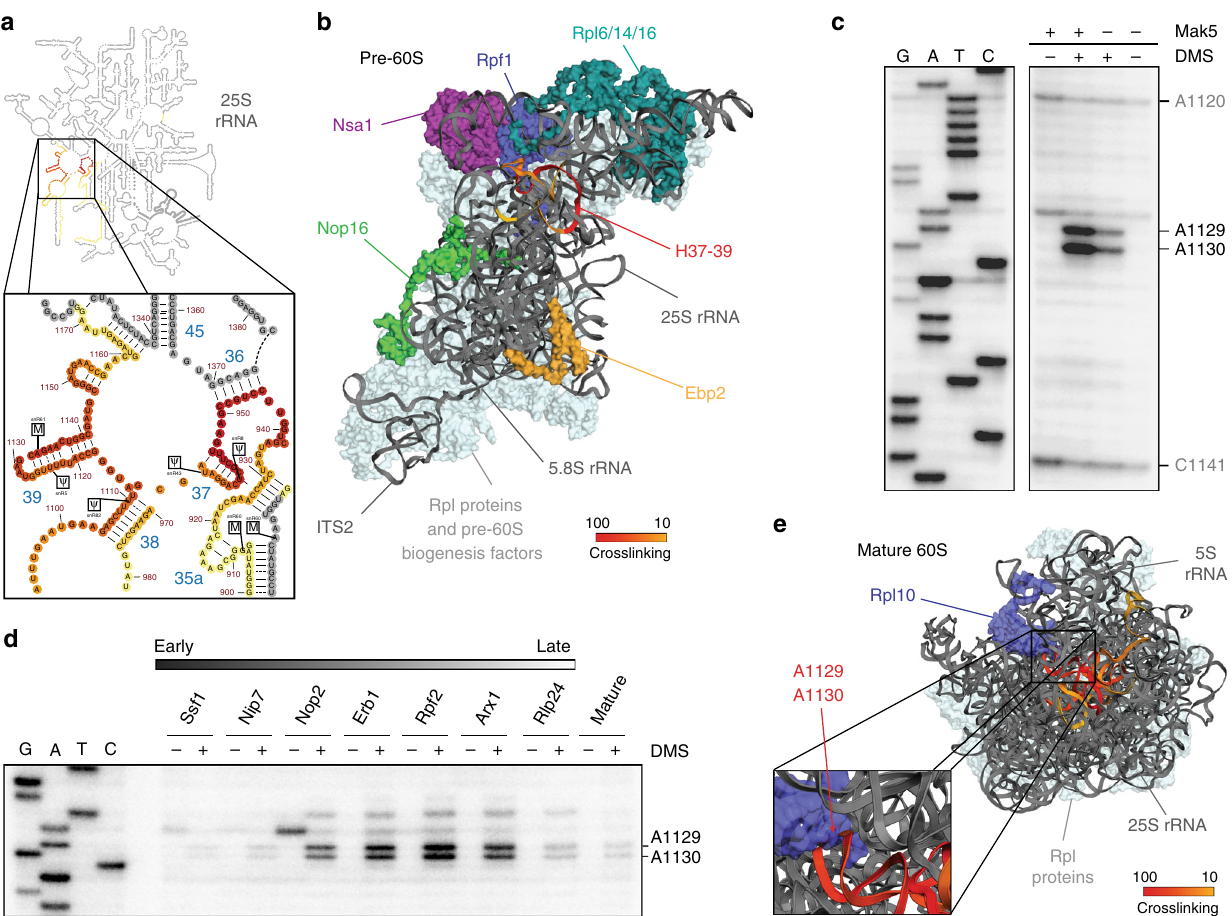
Fig. 5 Mak5 crosslinks to the 25S rRNA sequence that is later bound by Rpl10. a The number of sequence reads in the Mak5-HTP CRAC data corresponding to each nucleotide of the 25S rRNA sequence is shown on the secondary structure of the mature 25S rRNA using a colour code where the maximum number of reads (100%) is shown in red and lower numbers of reads (10%) are shown in yellow. A magni fi ed view of the Mak5 crosslinking sites in H36 – 37 and H39 is shown. b The number of sequence reads in the Mak5-HTP CRAC data corresponding to each nucleotide of the 25S rRNA sequence was modelled onto the tertiary structure of the 25S rRNA sequence in a pre-60S complex puri fi ed via Nsa1 and Nop2 (state 3; PDB: 6CB1 [https://www.rcsb.org/structure/6CB1]) using a colour code as in ( a ). Densities corresponding to speci fi c ribosomal proteins and pre-60S biogenesis factors are highlighted in various colours. c Nop2-containing pre-60S complexes puri fi ed from yeast expressing ( + ) or depleted ( − ) of Mak5 were immobilised on IgG sepharose and either treated with DMS ( + ) or left untreated ( − ). RNAs isolated from these complexes served as substrate for primer extension reactions and cDNA fragments were separated by denaturing PAGE, alongside a sequencing ladder, before visualisation. Differentially methylated nucleotide are indicated. Replicate experiments were performed and representative data is presented. d Mature 25S rRNA and pre-60S complexes isolated via different TAP or HTP-tagged biogenesis factors that bind sequentially to early, intermediate and late pre-ribosomal complexes as indicated were immobilised on IgG sepharose and then either treated with DMS ( + ) or left untreated ( − ). RNAs isolated from these complexes were used for primer extension reactions, and cDNA fragments were separated by denaturing PAGE and visualised using a phosphorimager. e The number of sequence reads in the Mak5-HTP CRAC data corresponding to each nucleotide of the 25S rRNA sequence was modelled onto the tertiary structure of the mature 60S subunit (PDB: 4V88 [https://www.rcsb.org/structure/4V88]) using a colour code as in ( a ). The ribosomal protein Rpl10 is highlighted in blue and a magni fi ed view of the contacts between 25S-H39 and Rpl10 is